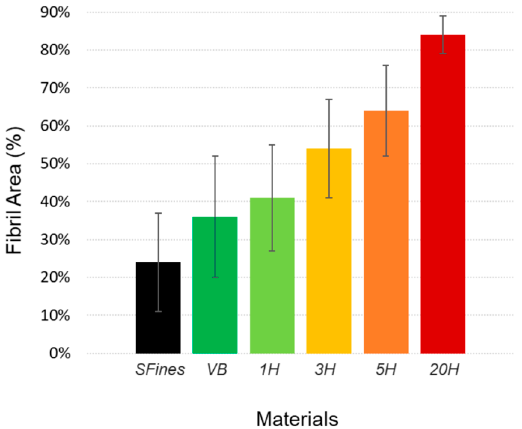
Figure 6. Result of the average Fibril Area for each additive resulting from the image analysis of the stained microscopic samples (average from 700 to 800 images analyzed per